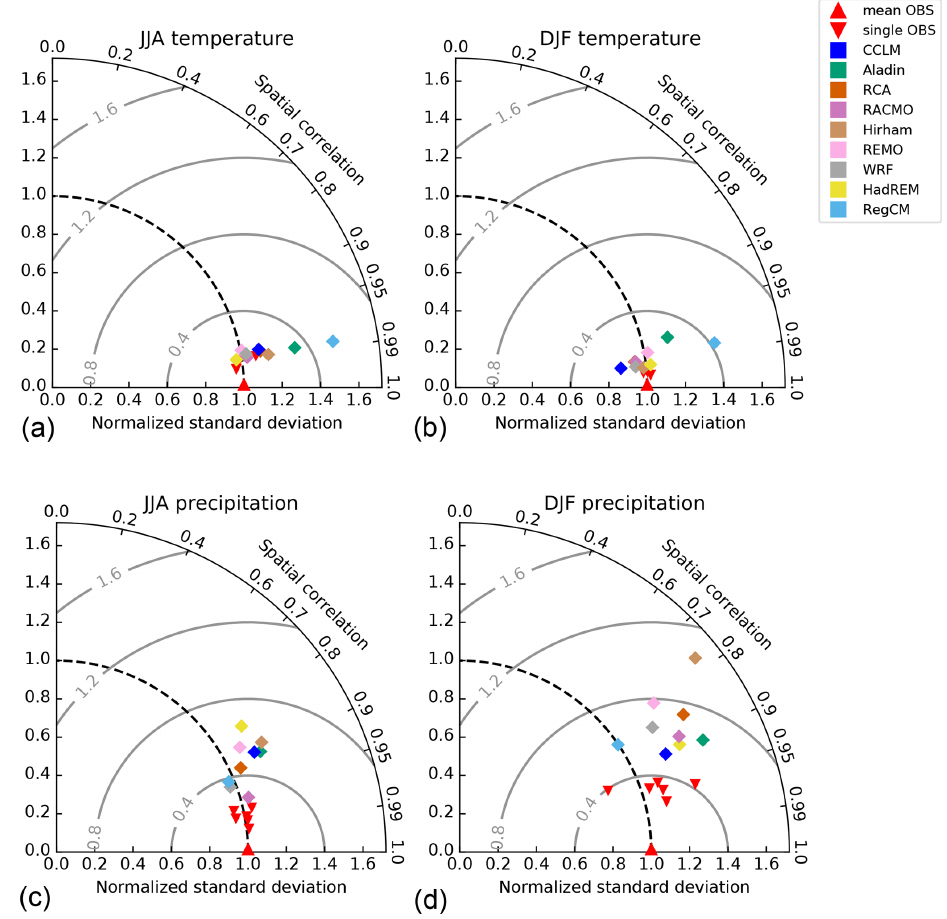
Figure 1. Spatial Taylor diagram exploring the model performance of the EUR-11 RCM ensemble, for temperature (a, b) and precipita- tion (c, d) for the boreal summer (June–July–August, JJA; a, c ) and boreal winter (December–January–February, DJF; b, d ) seasons. The reference observation is the ensemble mean of the products listed in Sect. 3.1, and the downward-facing red triangles indicate every single observational product. The colors represent different ERA-Interim (Dee et al., 2011)-driven RCM simulations, whereby the different RCM versions shown in the legend are Aladin53, RCA4, RACMO22E, HIRHAM5, REMO2015, WRF331F, HadREM3-GA7-05, RegCM4-6 and CCLM. The latter is represented here by COSMO-crCLIM-v1-1. See Kotlarski et al. (2014) or Vautard et al. (2020) for a documentation and comprehensive comparison of the different RCMs. More details about the evaluation metrics are given in Sect.